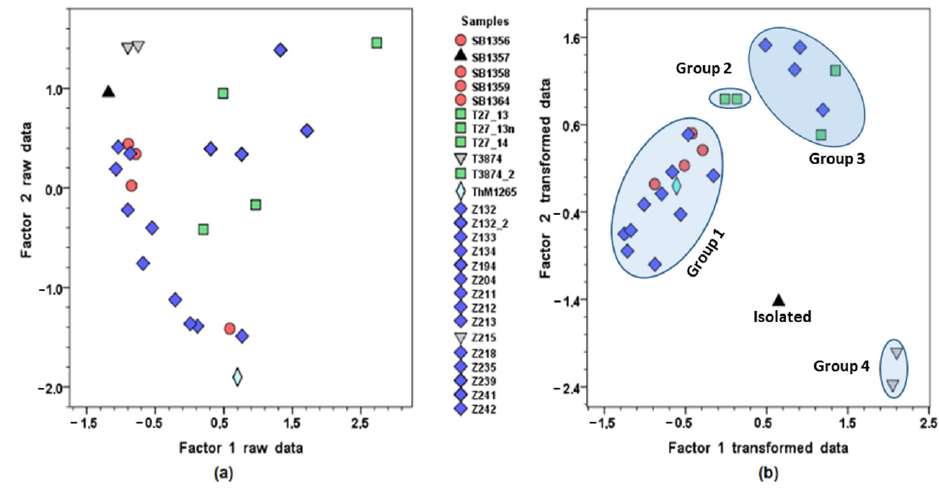
Figure 7. Plots of PC1–PC2: ( a ) raw data, and ( b ) transformed data.